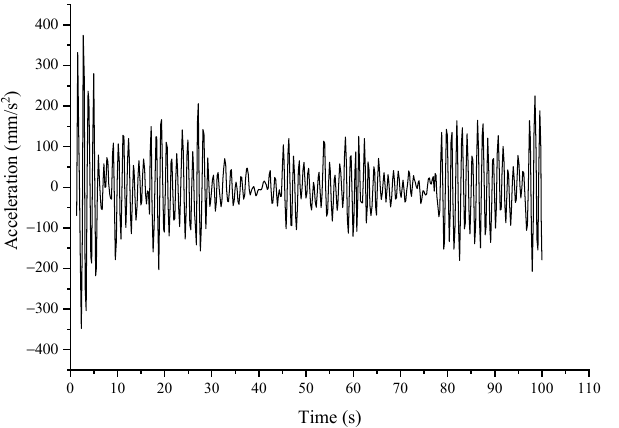
Figure 18. Response accelerations of the hub under ultimate ice conditions (ice thickness was 0.32 m and ice velocity was 0.75 m·s − 1 ).